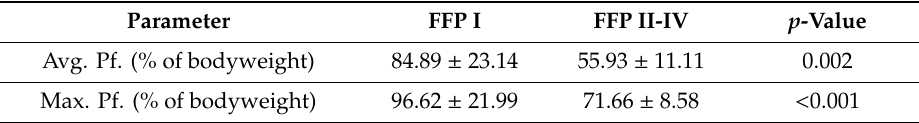
Table 7. FFP I vs. FFP